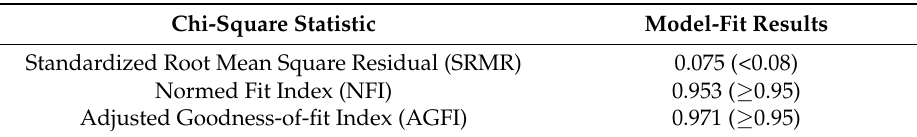
Table 7. Goodness of fit